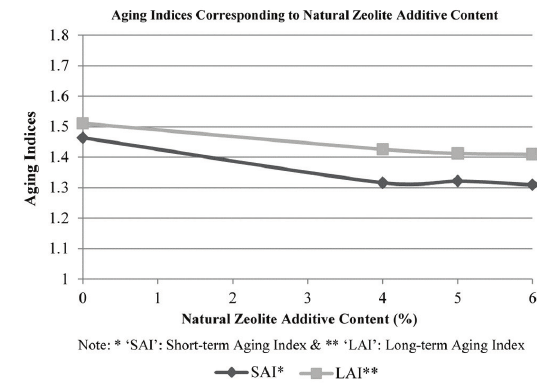
Figure 5. AI values corresponding to additive contents for natural zeolite modified mixtures.